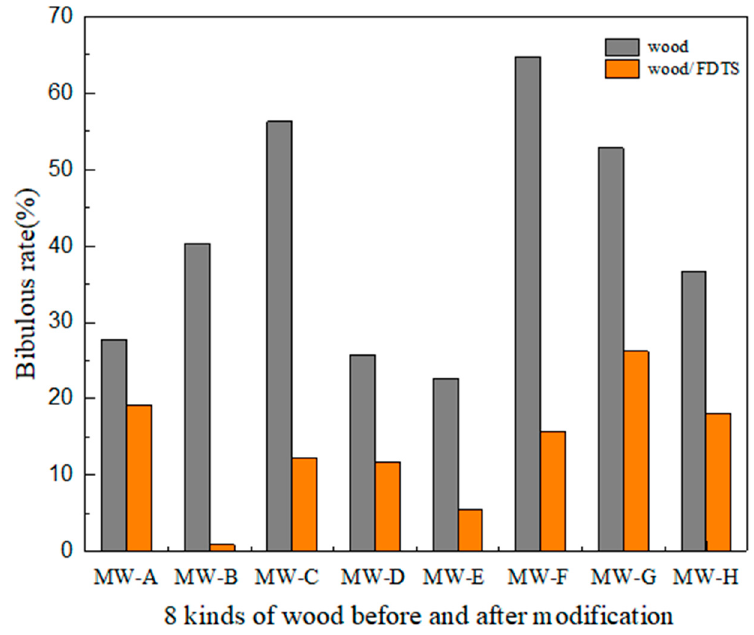
Figure 11. Water resistance test of untreated and modi fi ed wood.